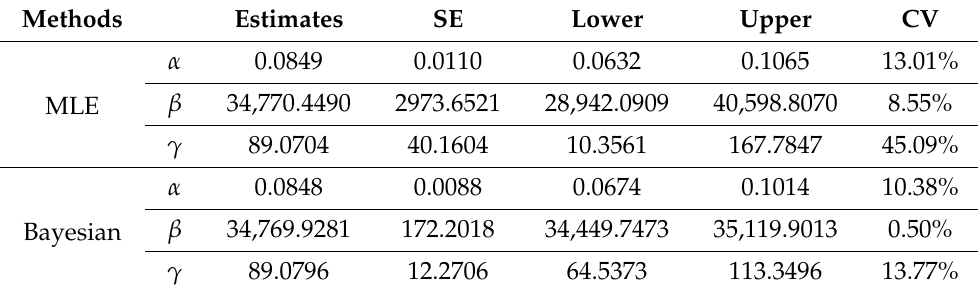
Figure 10. MLE of cdf, and pdf with empirical and histogram, QQ and PP of the KMWE model for food chain data. Table 8. Point and interval estimates and SE for parameters of the KMWE model for food chain